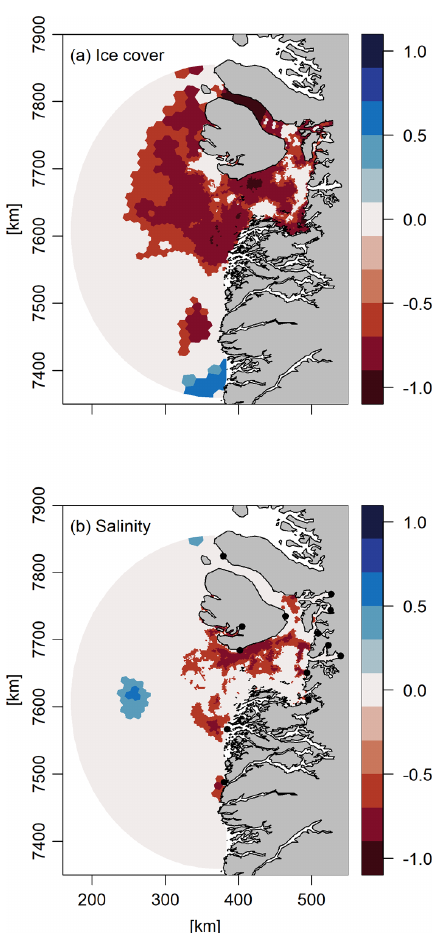
Figure 7. Correlation coefficients between the annual primary pro- duction (a) and average sea ice cover in March–April and (b) sur- face salinity across the period